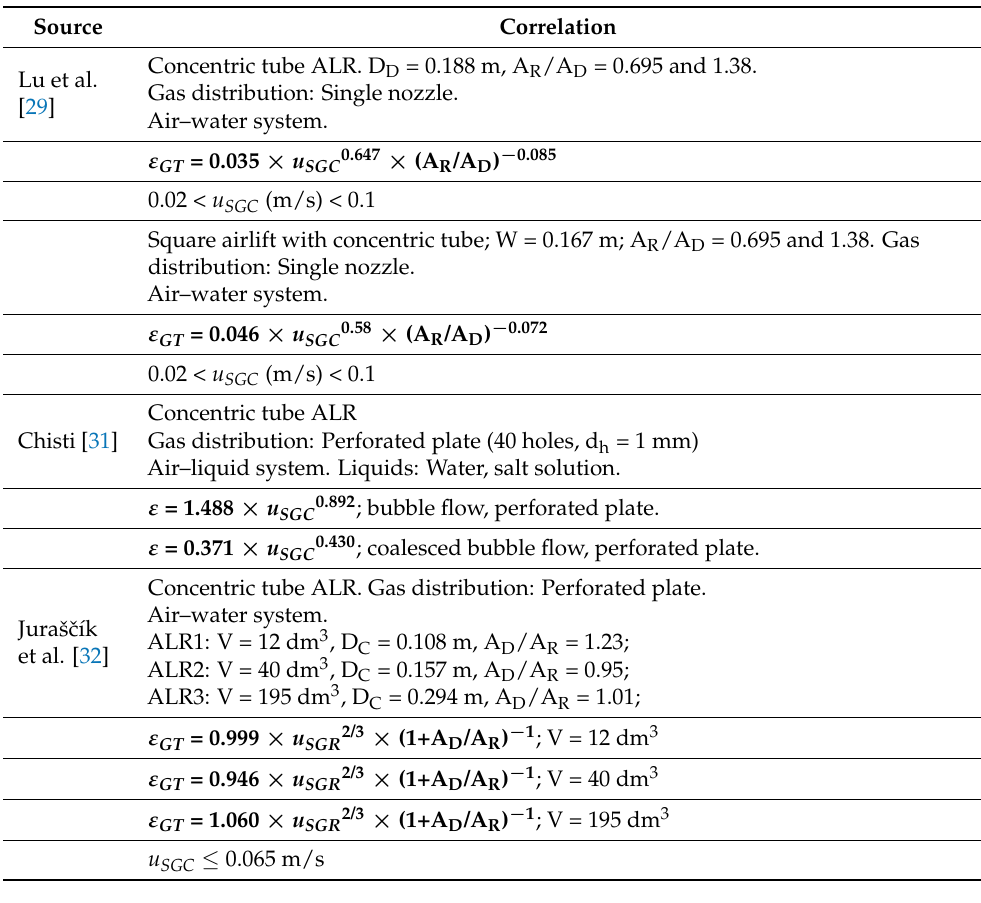
Table 2. Total gas holdup ε GT : selected published correlations; adapted from [19,31–35]. Source